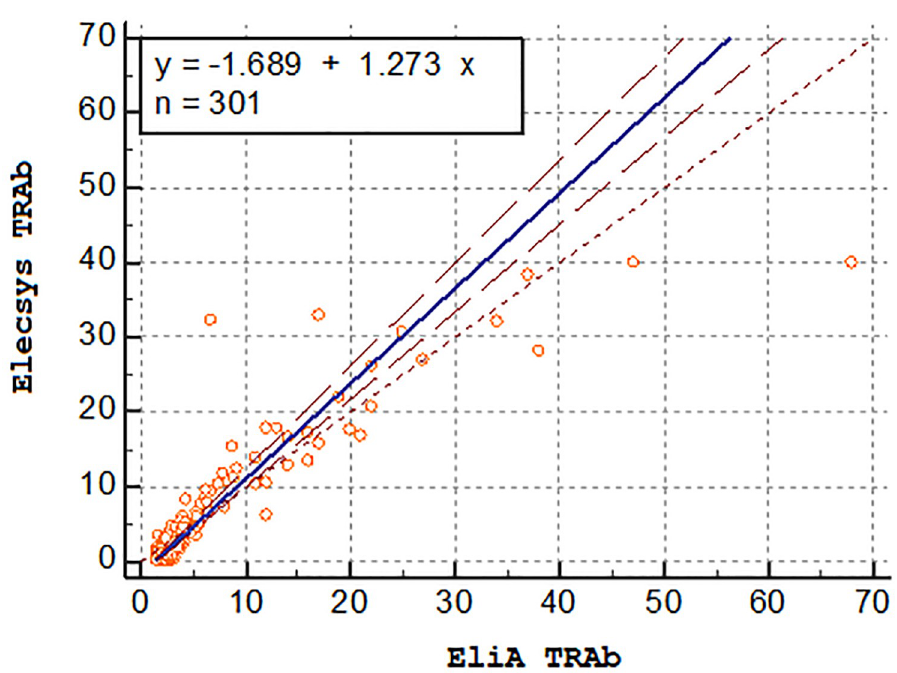
Fig 2. Passing-Bablok regression. Correlation between EliA ™ and Elecsys 1 TRAb. TRAb are displayed in UI/l. Dotted line (- - - -) corresponds to identity. Blue line corresponds to Passing Bablock regression and double dotted line (-- -- --) to 95% CI bands. Tests values are displayed as orange